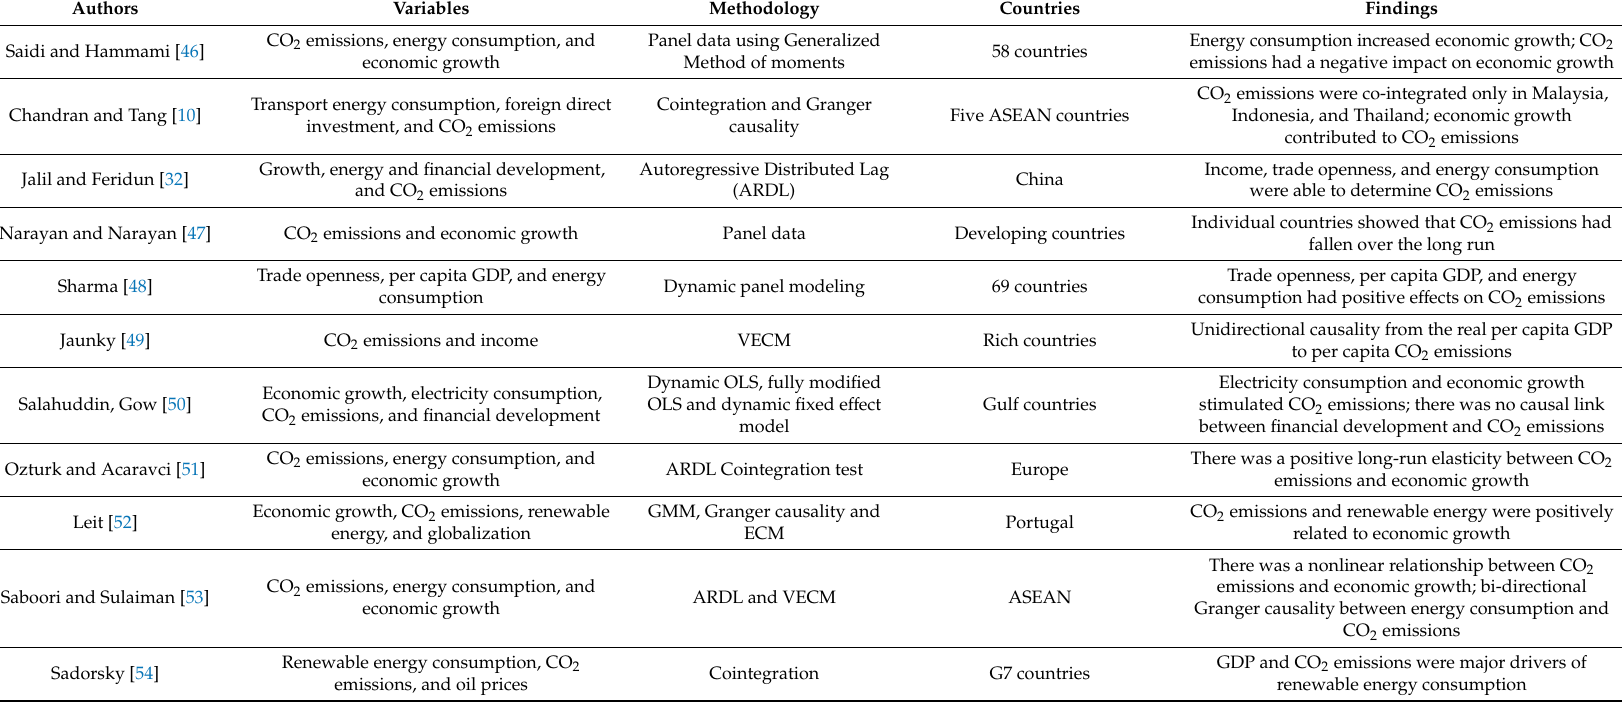
Table 1. Summary of empirical relationships among CO 2 emissions, energy consumption, and economic growth from 2009 to